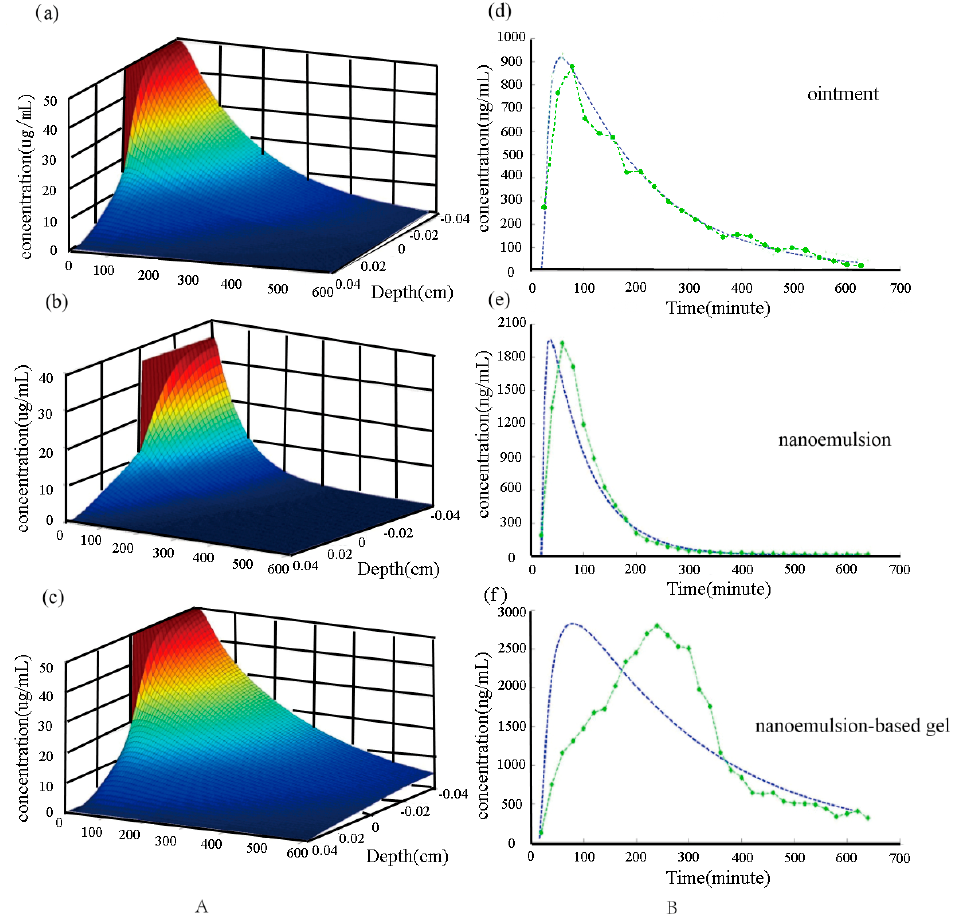
Figure 9. Two − layer model numerical simulation of the triptolide drug delivery system in a three − dimensional map: ( a — c ) ointment, nanoemulsion, and nanoemulsion − based gel, respectively. Comparison between experimental data and numerical results: ( d — f ) ointment, nanoemulsion, and nanoemulsion − based gel, respectively